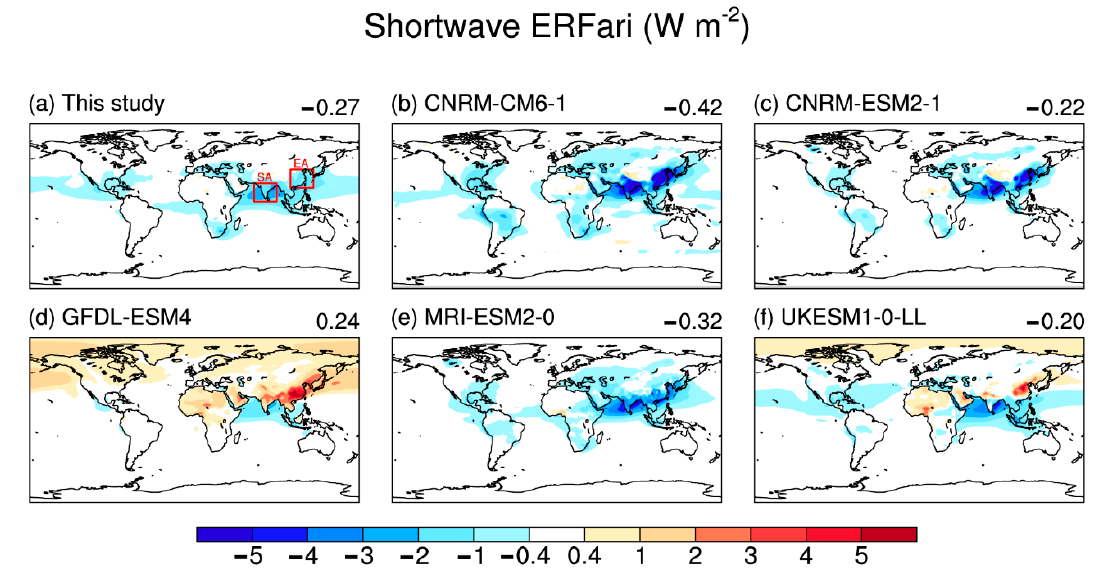
Figure 2. Comparison of annual mean shortwave effective radiative forcing of aerosol-radiation interactions in this study ( a ) and five available ( b – f ) Coupled Model Intercomparison Project phase 6 (CMIP6) model results.